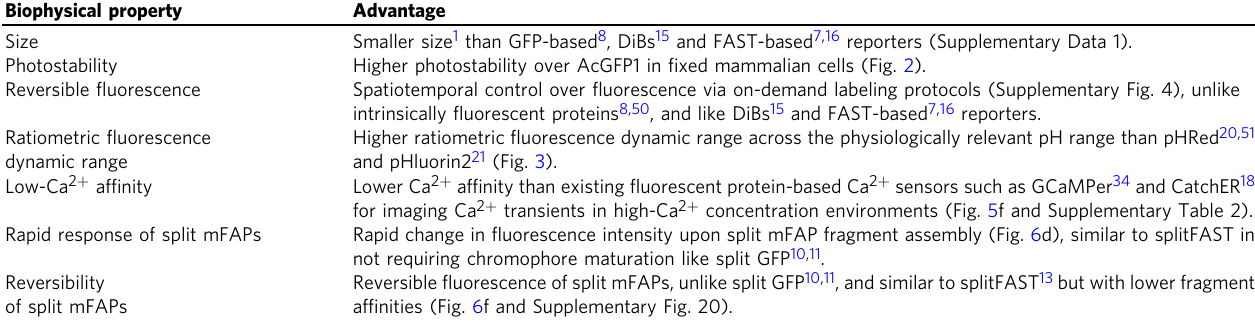
Table 3 Potential advantages of de novo designed mFAP sensors over existing fl uorescent protein-based reporters and sensors. Biophysical